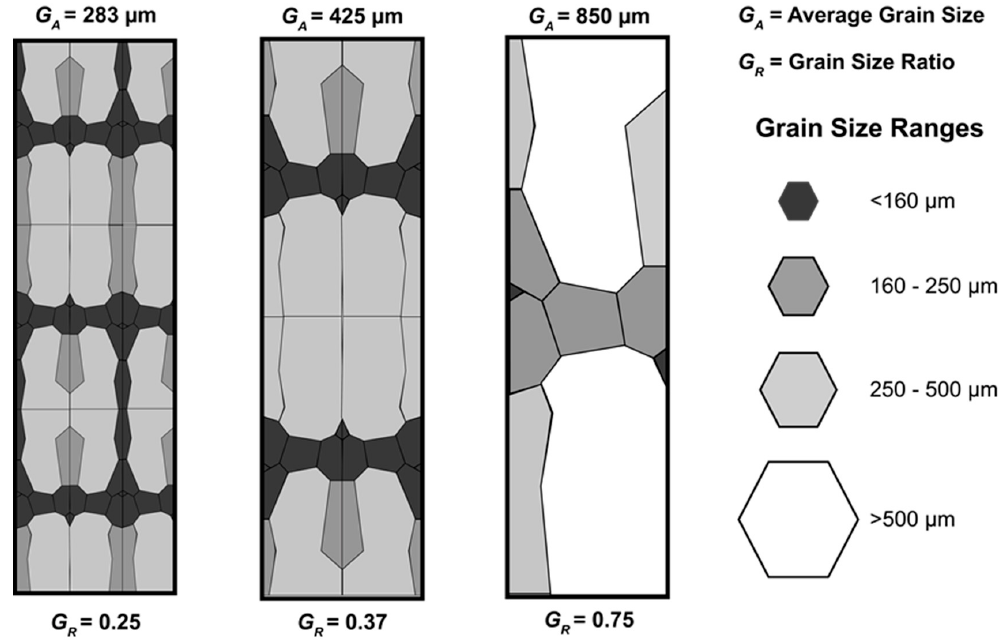
Figure 5. The grain size distributions of the 47- µ m, 66- µ m, and 97- µ m grains.